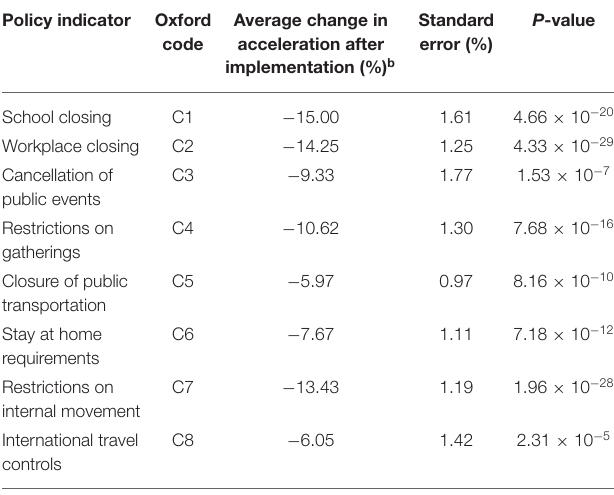
TABLE 1 | Effect of mobility restrictions on variation of COVID-19 acceleration (cases/day 2 ) during exponential growth a . Policy indicator Oxford